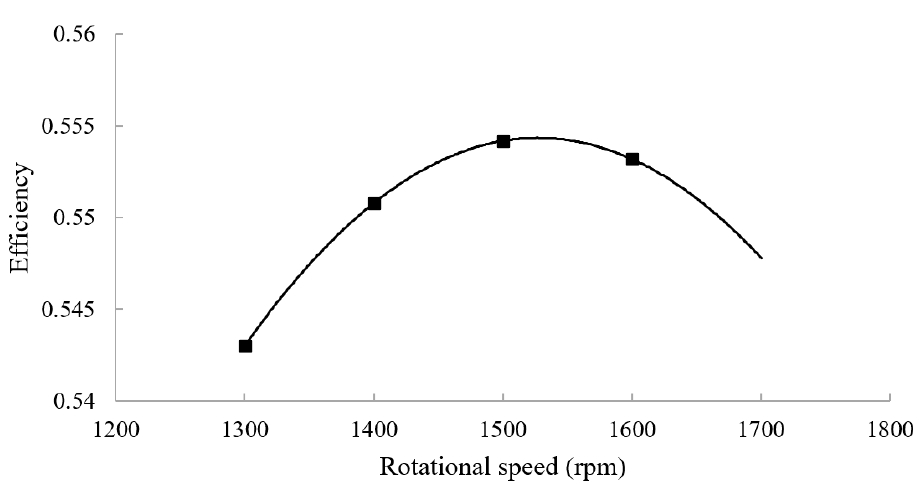
Figure 8. Efficiency against rotational speed for the imported turbine when operating at a head of 14.7 m. 14.7